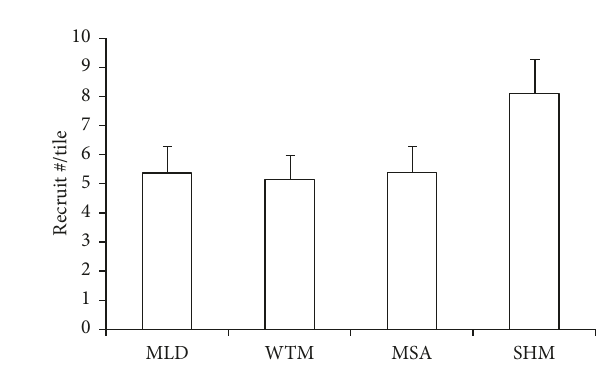
Figure 3: Coral recruit density (#/tile) in four Kenyan protected reef